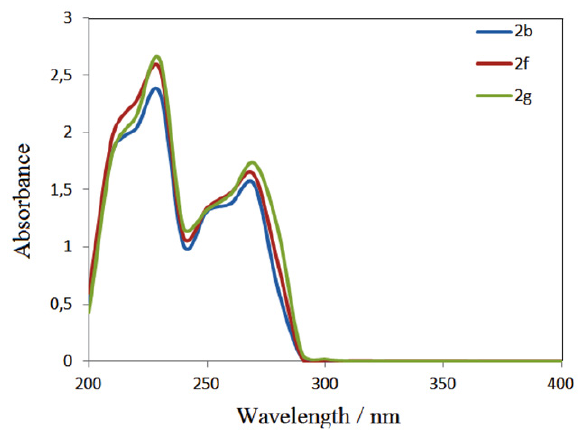
Fig. 5. UV–Vis spectra of the 2b , 2f and Table 5. The experimental and calculated UV-Vis parameters of the compounds 2b , 2f and 2g .